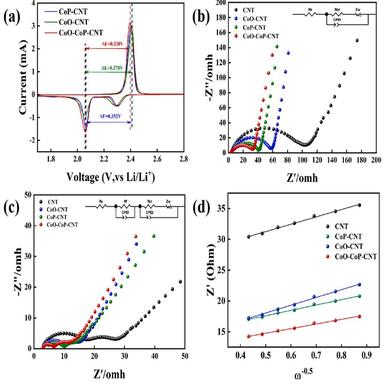
(a) Comparison of CV curves of S/CoO-CoP-CNT, S/CoO-CNT and S/CoP-CNT at 0.1 mV s − 1 sweep speed. S/CoO-CoP-CNT, S/CoO-CNT, S/CoP-CNT and S/ CNT positive electrode (b) EIS diagram before the cycle and (c) EIS diagram after 50 cycles and (d) the relationship between Z′ and ω− 0.5.